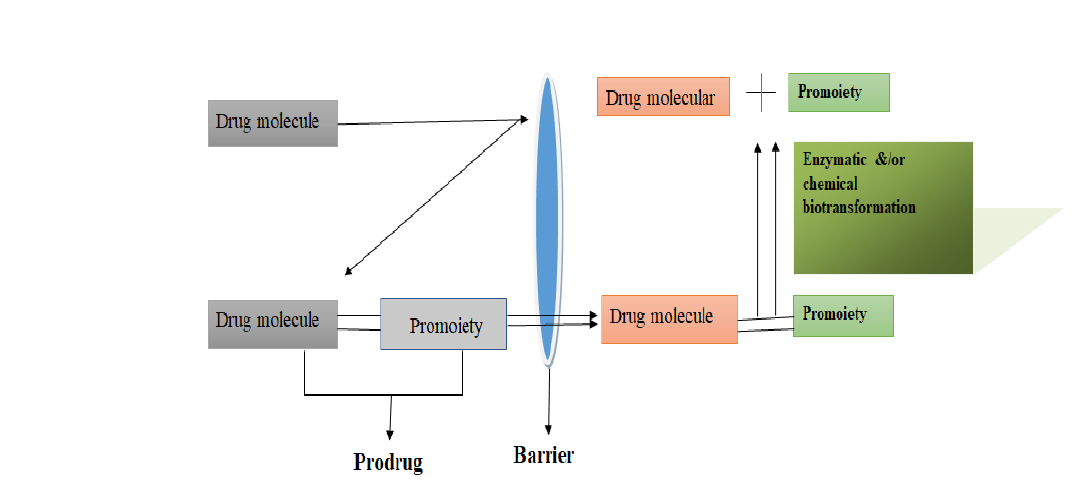
Fig. 6. Representation of prodrug approach for brain delivery